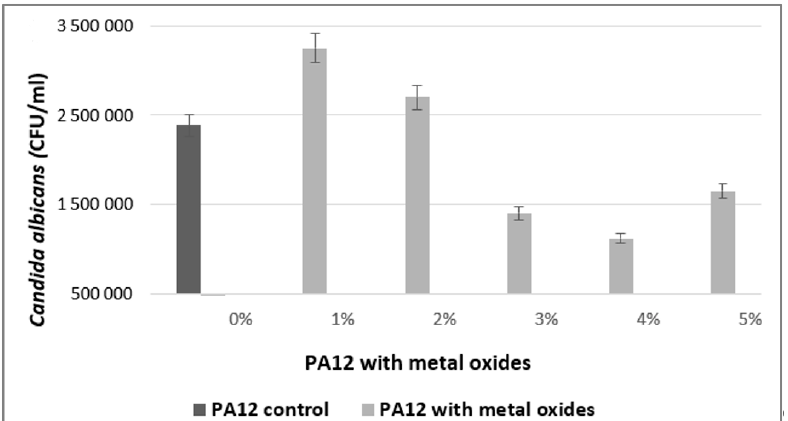
Figure A1. Antifungal activity of the PA12 with metal oxides assessed using the AATCC TM100-